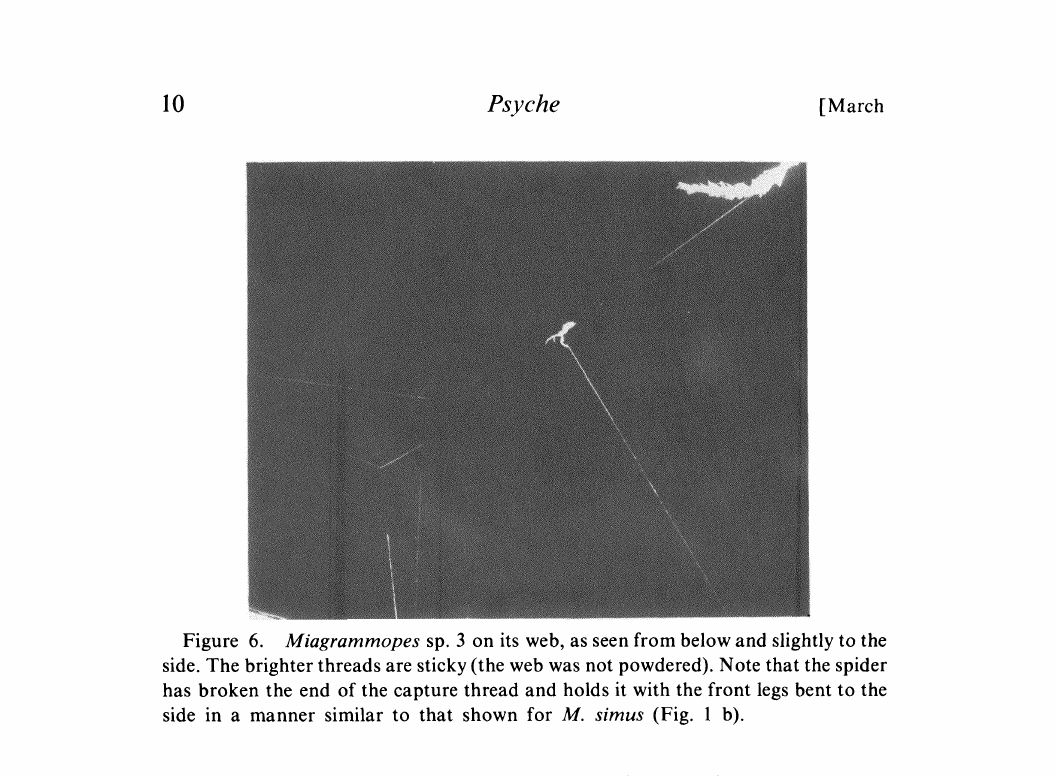
Figure 6. Miagrammopes sp. 3 on its web, as seen from below and slightly to the side. The brighter threads are sticky (the web was not powdered). Note that the spider has broken the end of the capture thread and holds it with the front legs bent to the side in a manner similar to that shown for M. simus (Fig.